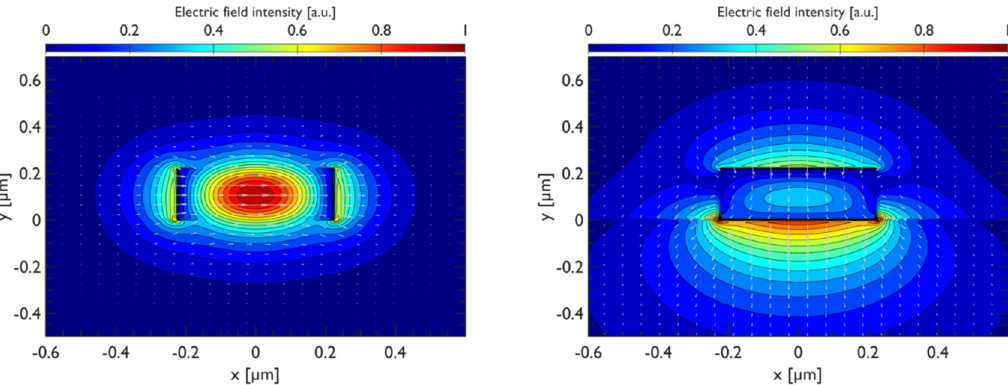
Figure 3. ( Left ): The optical modes supported by a standard 450 nm × 220 nm SOI waveguide. ( Left ): Transverse electric (TE) mode. ( Right ): Transverse magnetic (TM) mode.